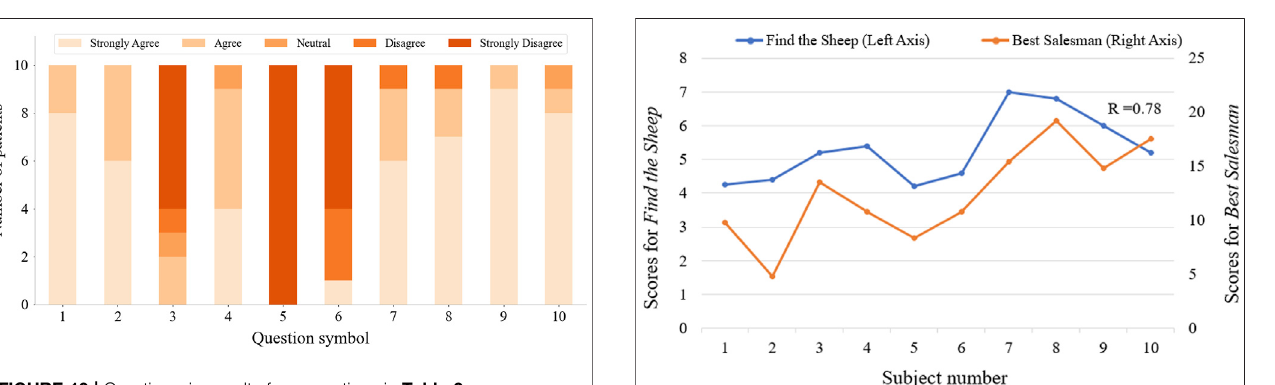
FIGURE 10 | Questionnaire results from questions in Table 2 .